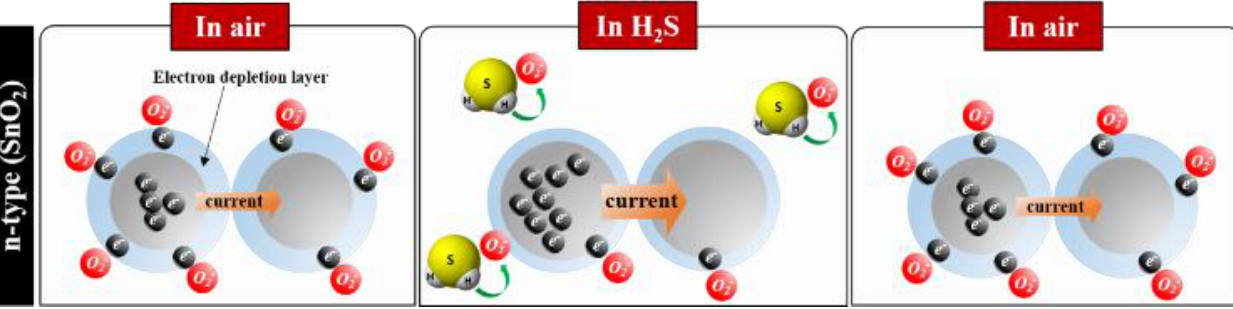
Figure 1. H 2 S-sensing mechanism of SnO 2 .